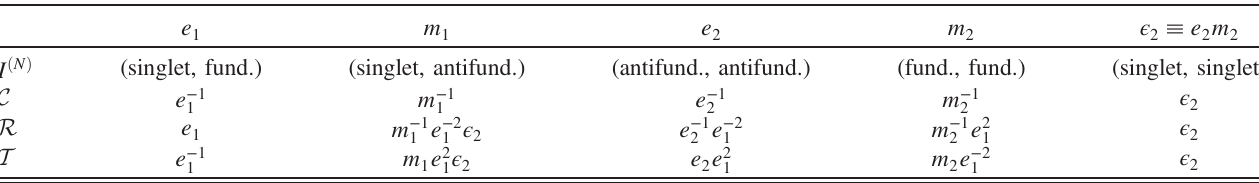
TABLE IV. Projective symmetry actions on the topological sectors of the Z 4 × Z 2 TO that realizes the I ð N Þ anomaly of root 2. In the row corresponding to I ð N Þ , the two entries in each parentheses represent the representations of this excitation under the associated spin group of the corresponding SO ð N Þ and SO ð N − 4 Þ subgroups of I ð N Þ , where “ fund. ” ( “ antifund. ” ) represents fundamental (antifundamental) representation of the relevant spin group [when N ¼ 6 , the fund. (antifund.) in the second entry in the parentheses means charge 1 = 2 ( − 1 = 2 ) under SO ð 2 Þ ⊂ I ð 6 Þ ]. Their partners under C , R , and T are shown as above. Note that one can further specify data like T 2 for various anyons, but it is unnecessary for our purpose. e 1 m